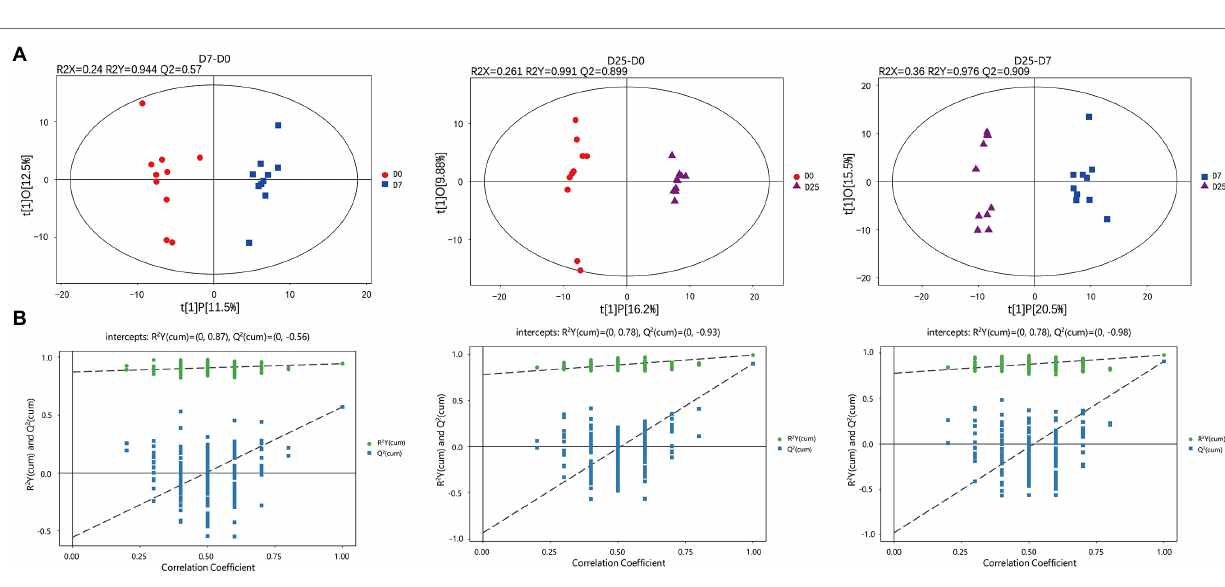
from origin represent the higher VIP value of the ions, and the higher VIP value represent the greater contribute to the difference between the two sample groups, we selected the ions with VIP >1 and further confirmed to the potential metabolite biomarkers of fatty liver formation ( Supplementary Figure S4 ).